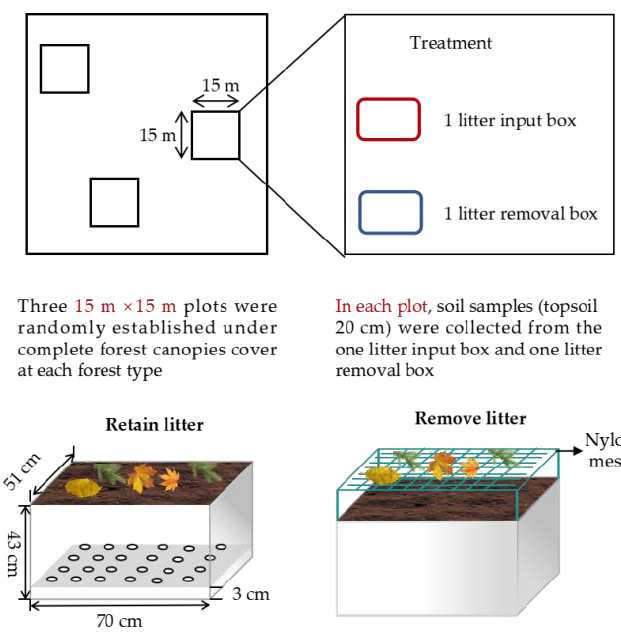
Figure 1. Schematic diagram of sample plot setting and collection.